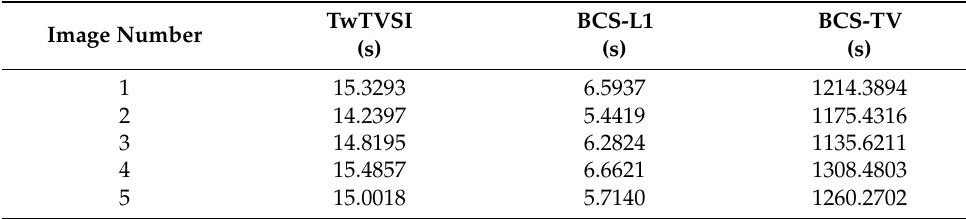
Table 4. Reconstruction time of each